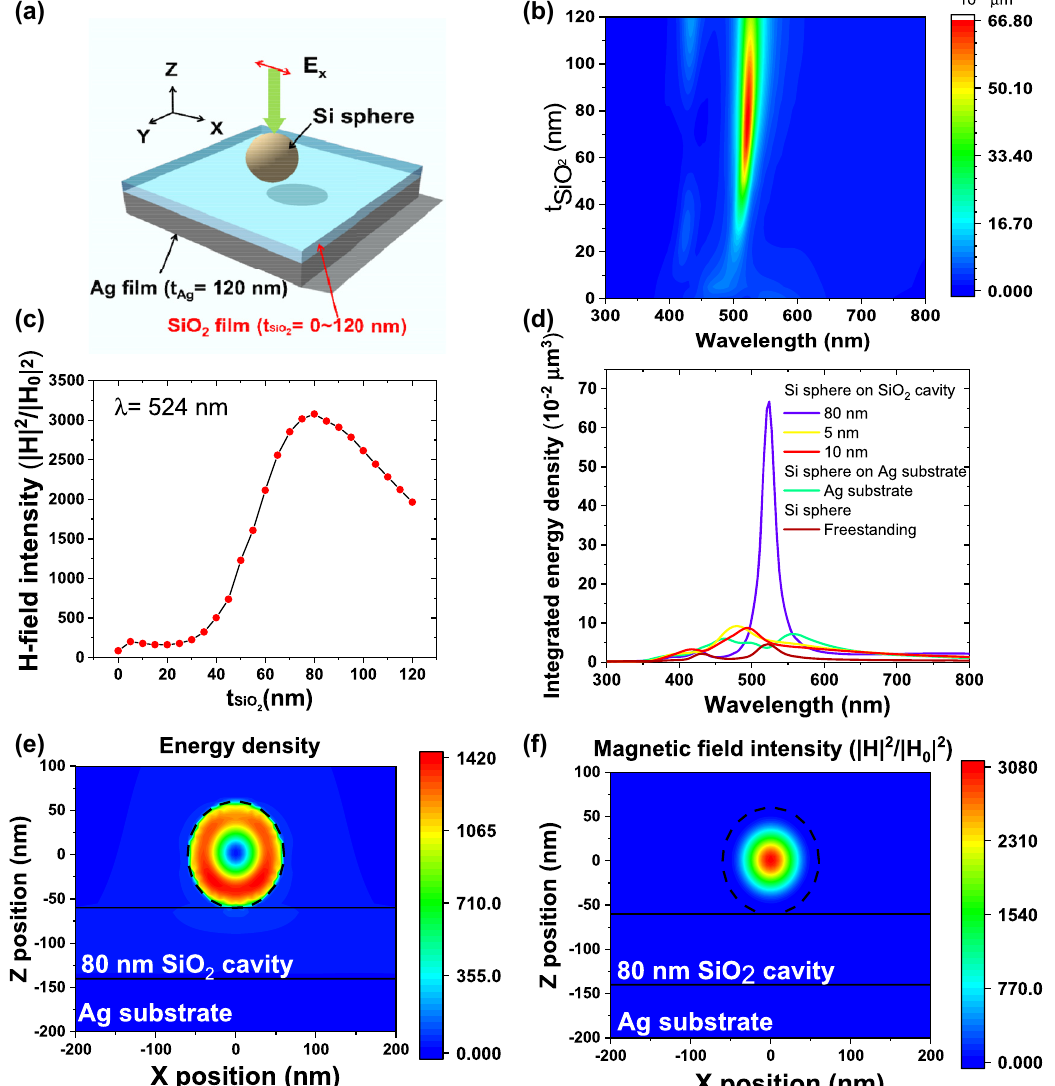
film of various thicknesses, used to 2 is the thickness of SiO . (b) Contour map of integrated SiO2 2 layer in the thin-film cavity substrate. (c) Calculated magnetic field 2 layer in the thin-film cavity substrate. (d) Integrated 2